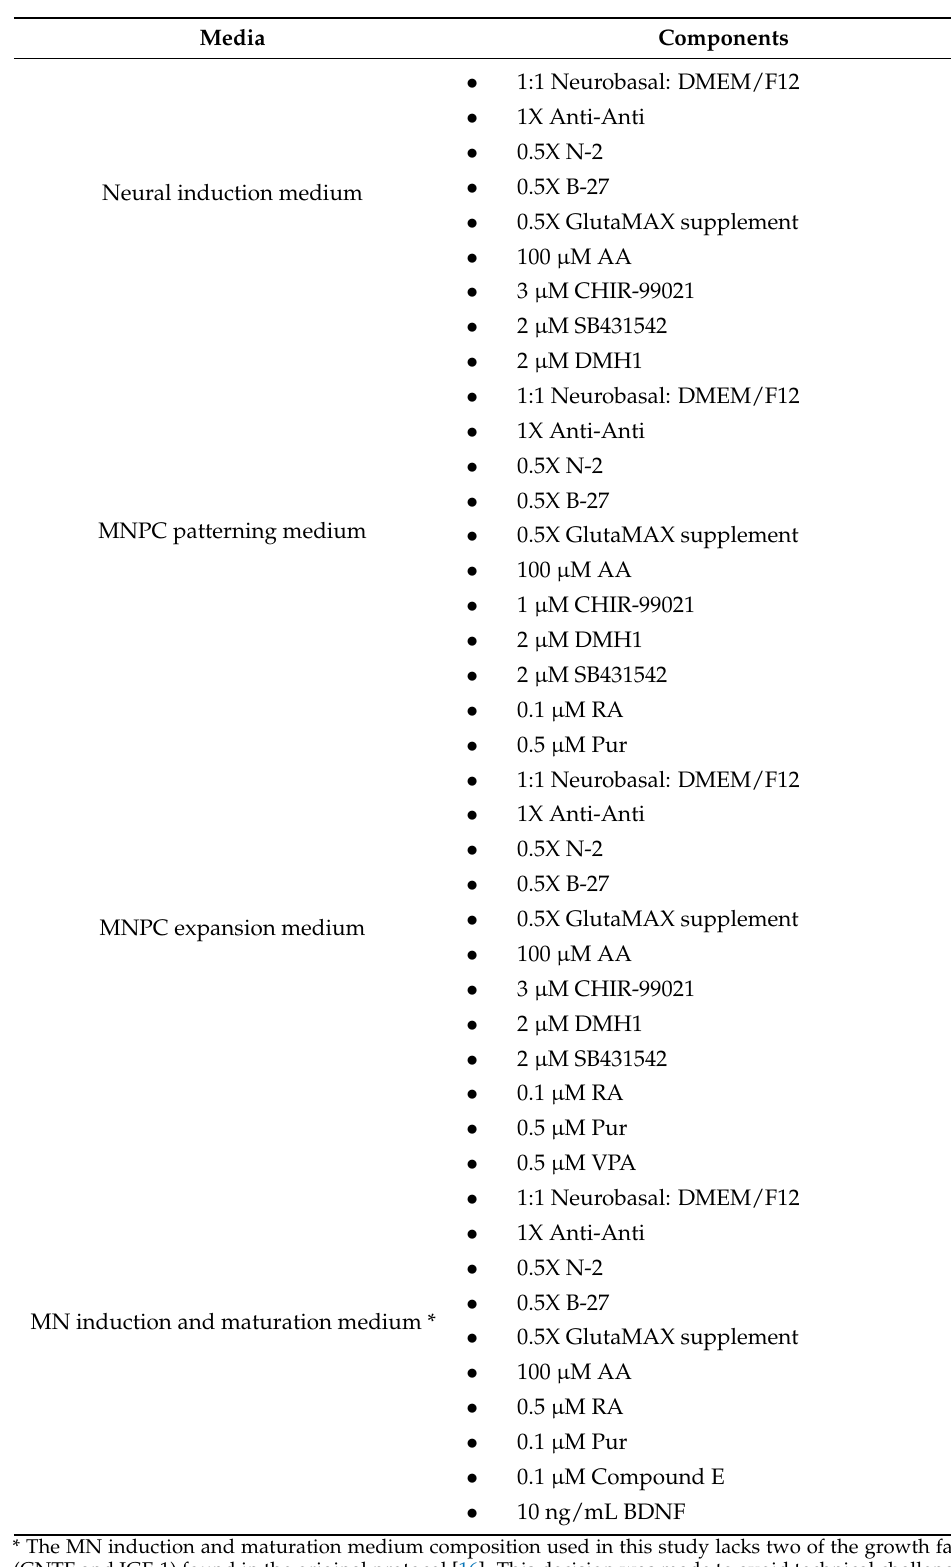
Table 2. Media composition